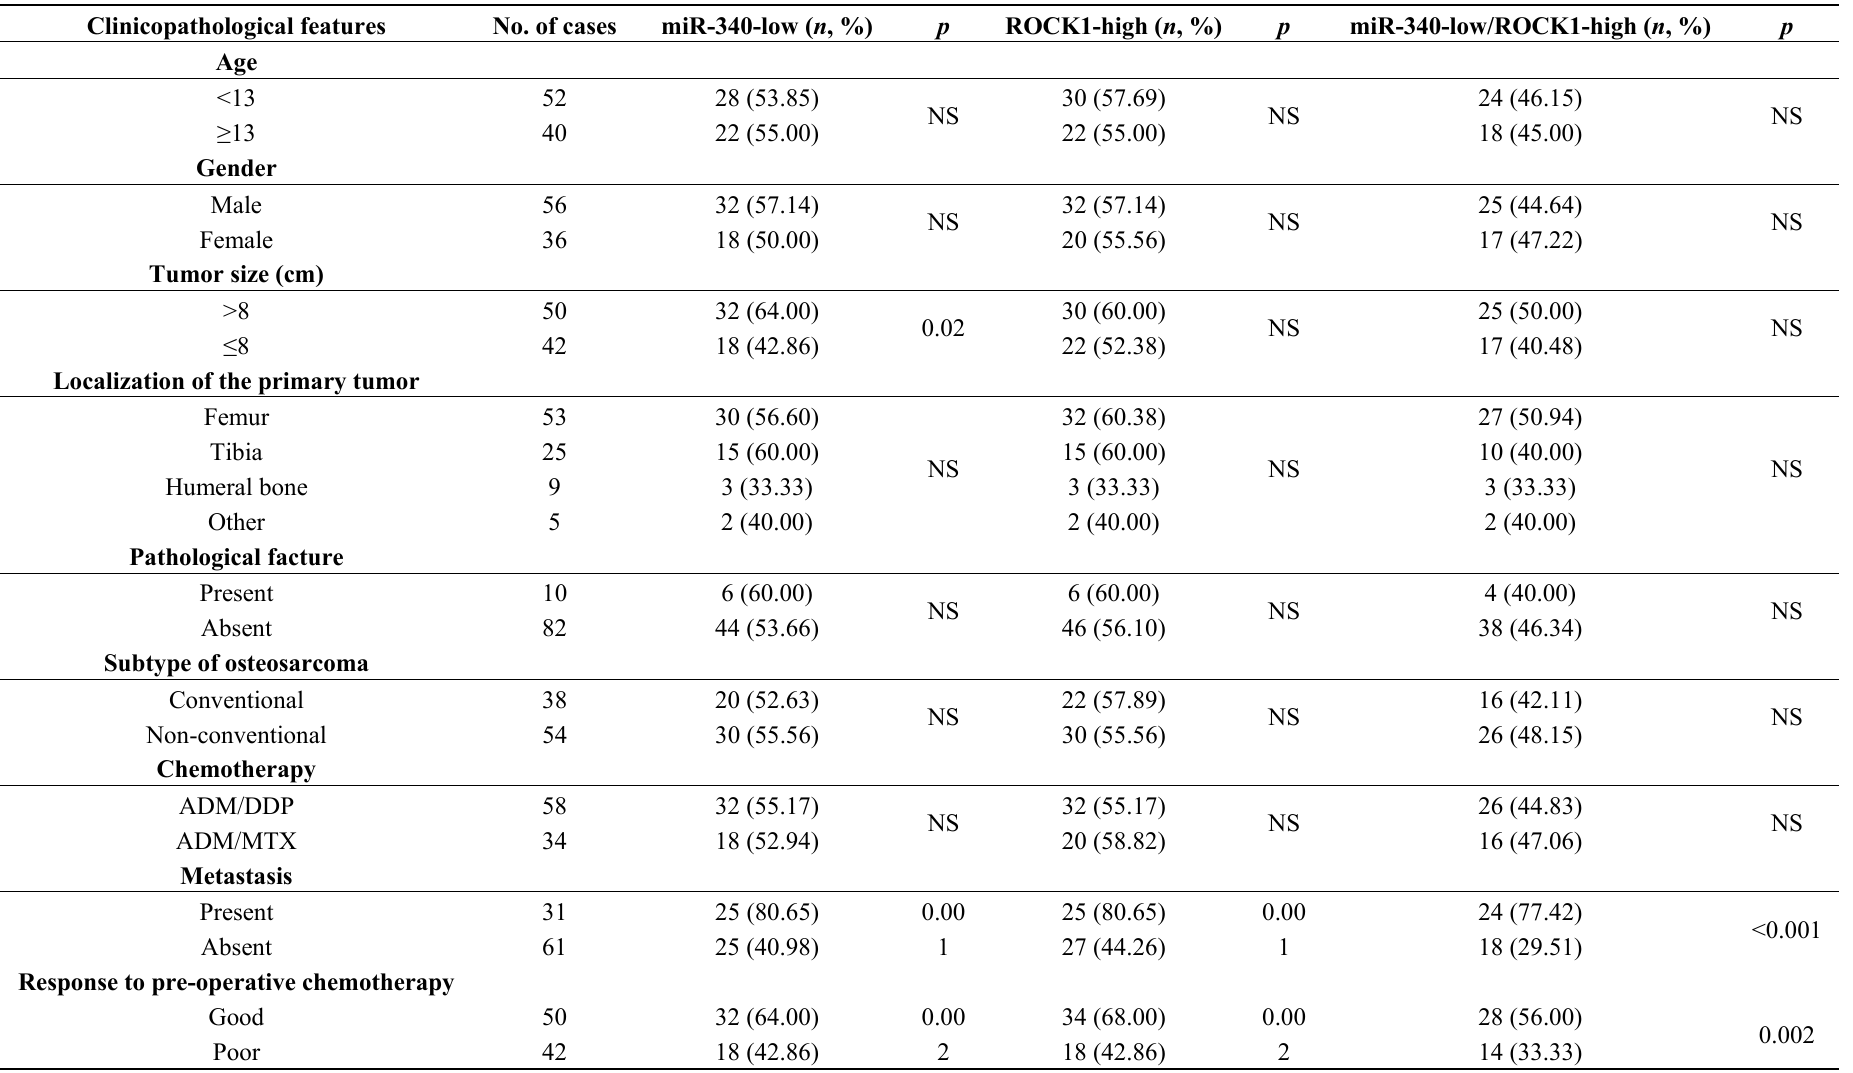
Table 1. Association of miR-340 and ROCK1 expression with clinicopathological features of pediatric osteosarcoma. Clinicopathological